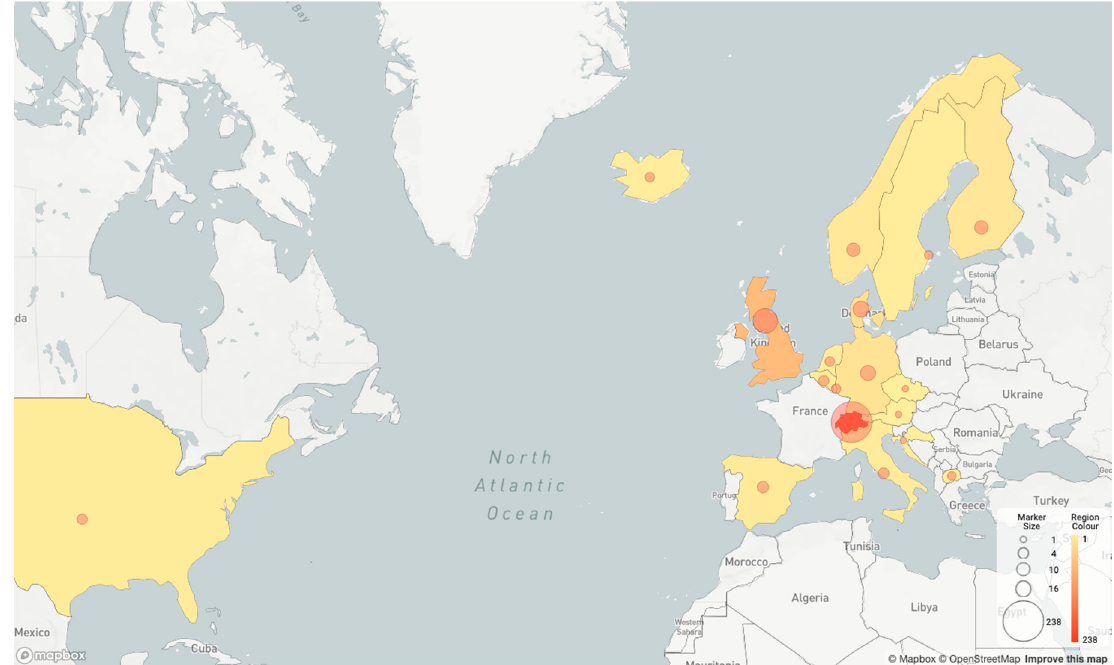
Figure 2. Geographic distribution of isolates from lineage B.1.1.39 according to pangolin [60] . France (2), Rwanda (1), New Zealand (1), Australia (1), Czech Republic (1), and Croatia (1) are not shown in the map generated with pangolin, but the countries reported isolates from the B.1.1.39 lineage, according to GISAID.org (isolate number in brackets).